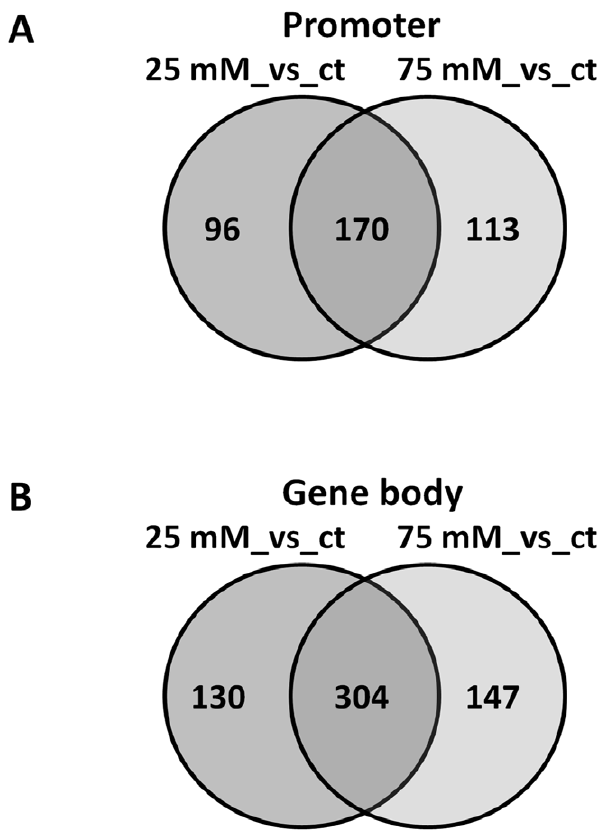
Figure 1. Venn diagrams showing the number of the similarly and differentially methylated promoter regions (A) and gene body regions (B) in the progeny of plants exposed to 25 and 75 mM NaCl as compared to the progeny of control plants.